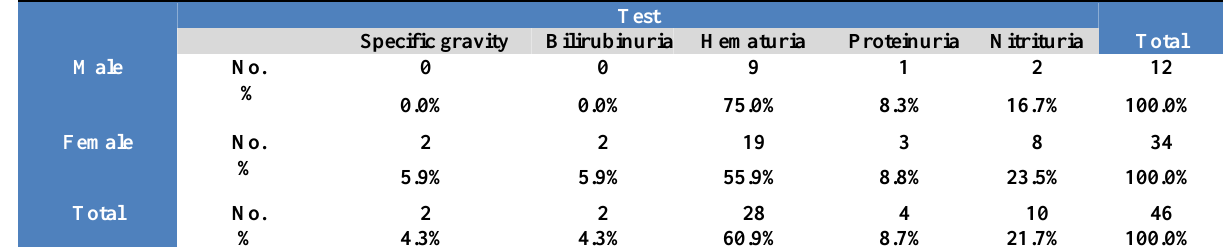
Table, 1: Abnormal urinalysis results in both